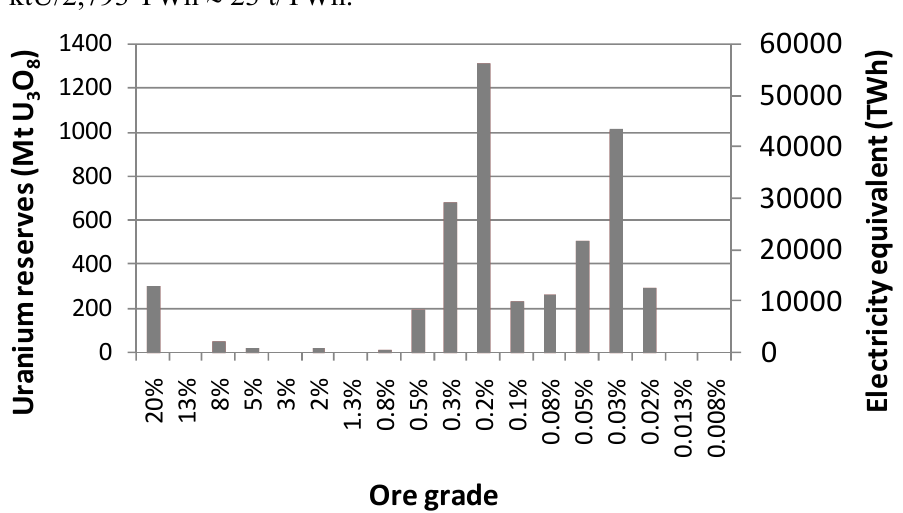
Figure 22. Uranium reserves [103,108]. Electricity equivalent calculated using 65 ktU/2,793 TWh  23